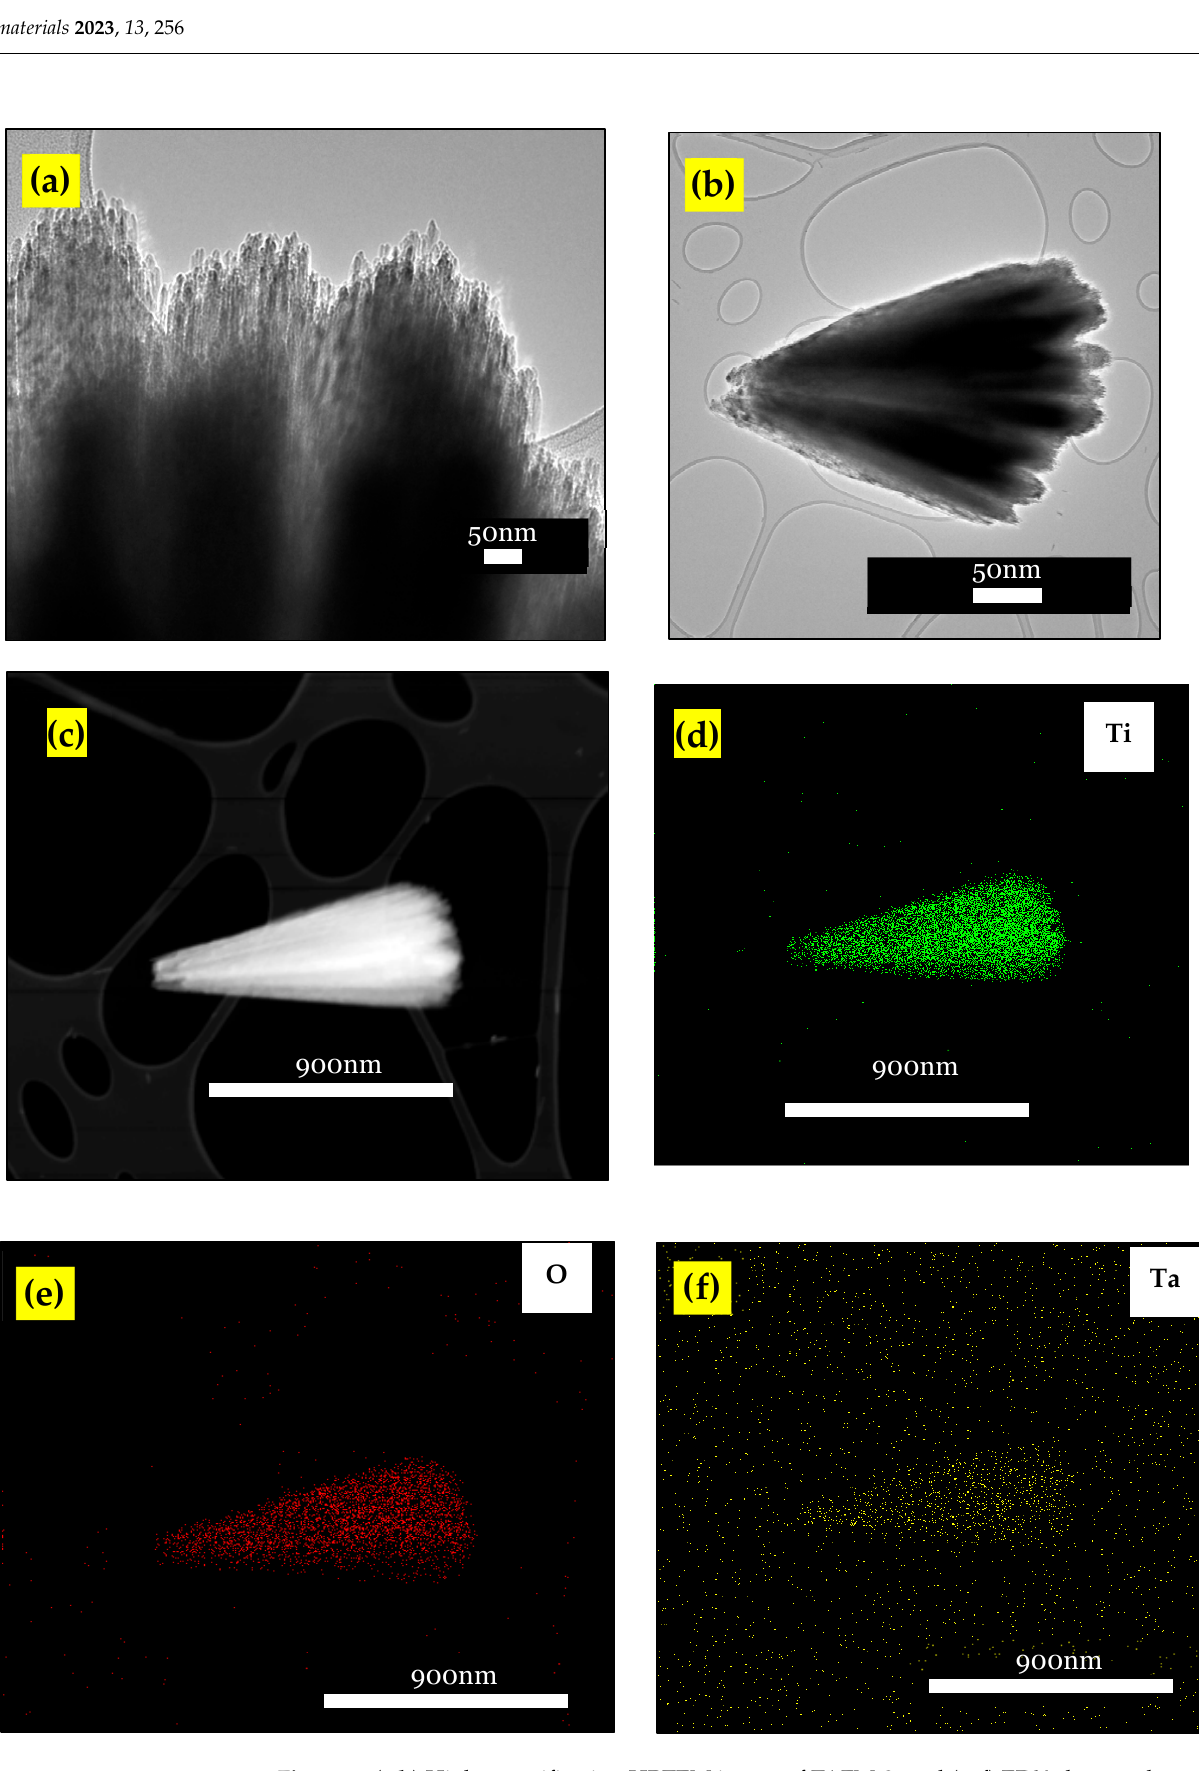
Figure 2. ( a , b ) High magnification HRTEM image of TAFM-3, and ( c – f ) EDX elemental mappings of TAFM-3.